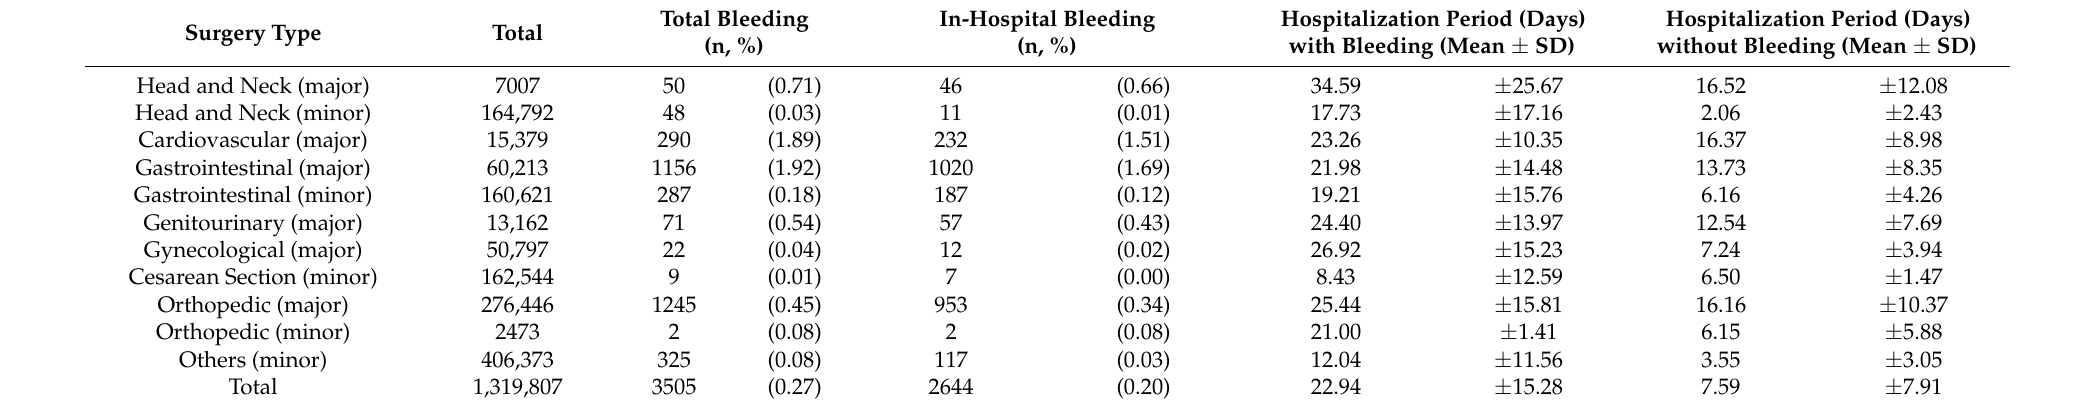
Table 2. Gastrointestinal bleeding prevalence and hospitalization period by surgery